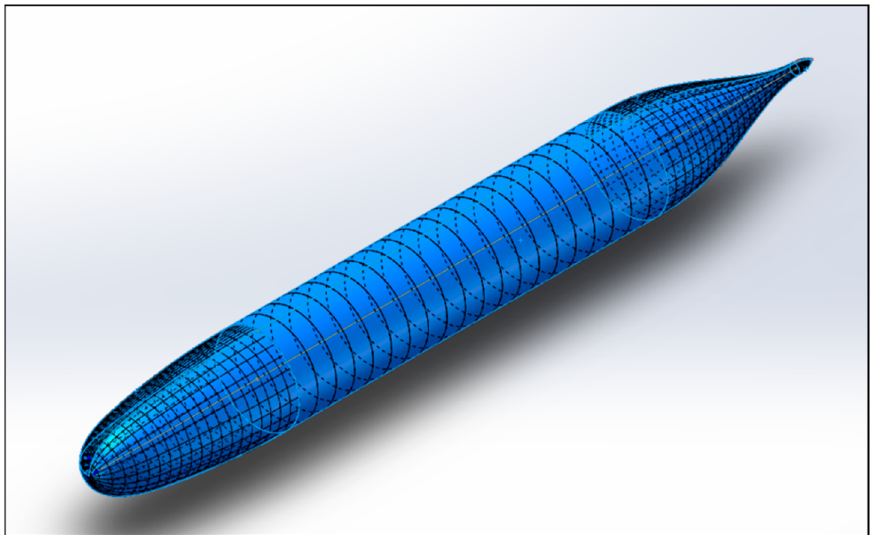
Figure 1. Schematic diagram of SUBOFF-AFF-1.